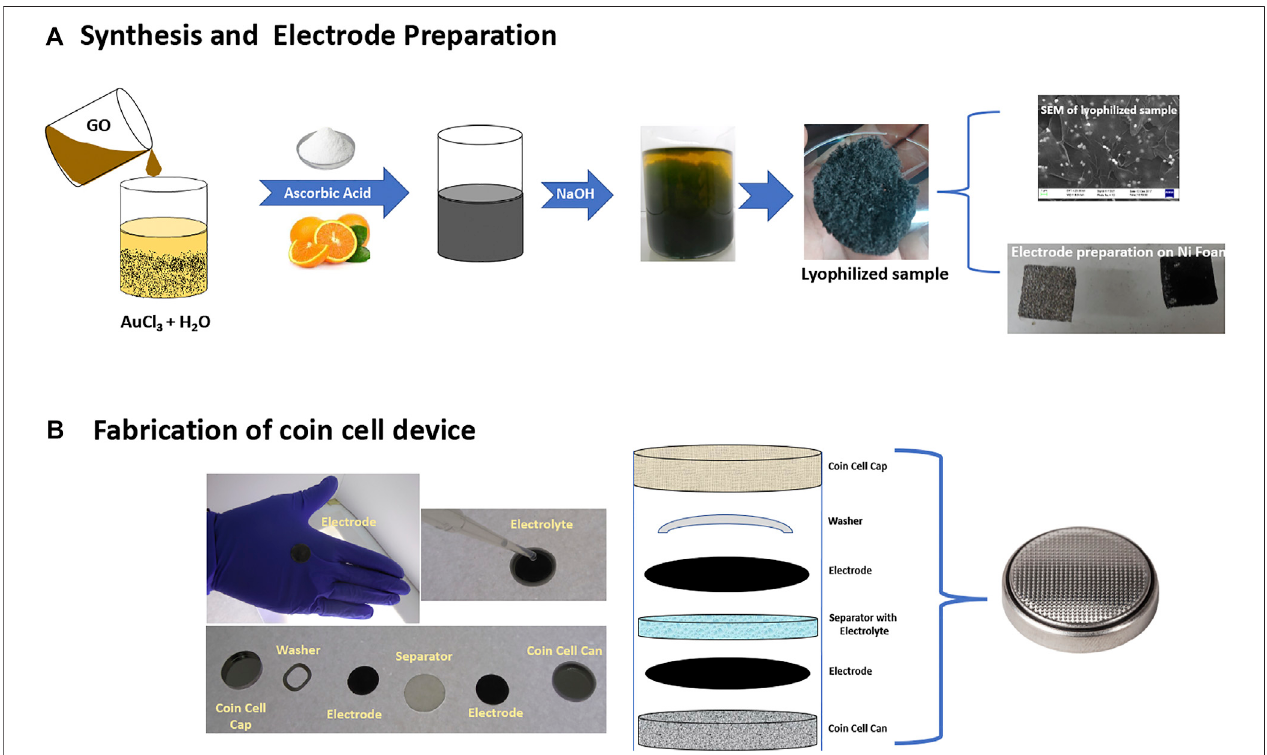
FIGURE 1 | (A) Synthesis of graphene-Au composite and electrode preparation for three electrode con fi gurations. (B) Coin cell supercapacitor device fabrication.